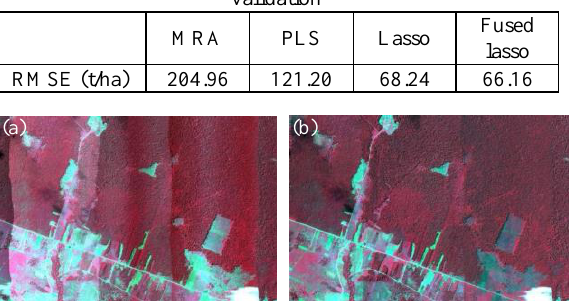
Figure 3. Reflectance data in this study site (a) without, and (b) with correction of radiometric distortion